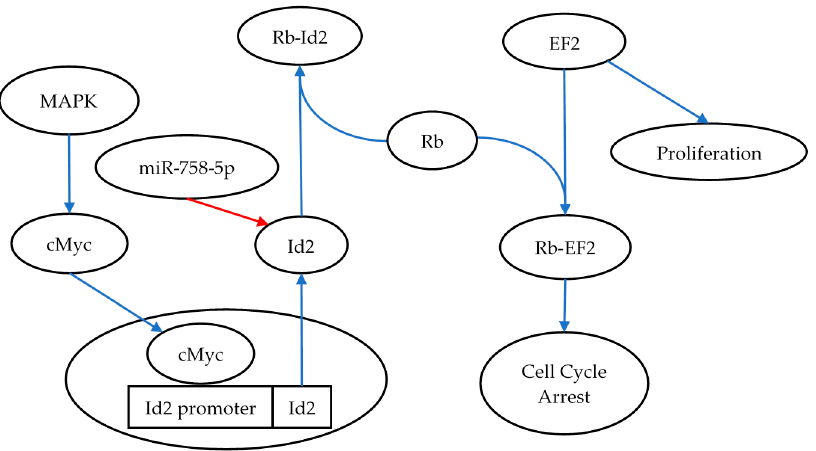
Figure 4. Id2’s role in reversing cell cycle arrest, illustrating the role of miR-758-5p in regulating Id2 and the consequence of upregulating Id2 via the activation of the MAPK signaling pathway. As part of the recovery process following radiation exposure, Id2 is expressed and binds to Rb. This interaction prevents binding to its other binding partner EF2, thus inducing cell proliferation [46]. The blue arrows in the figure represent pathway activation, whereas the red arrows illustrate path- way